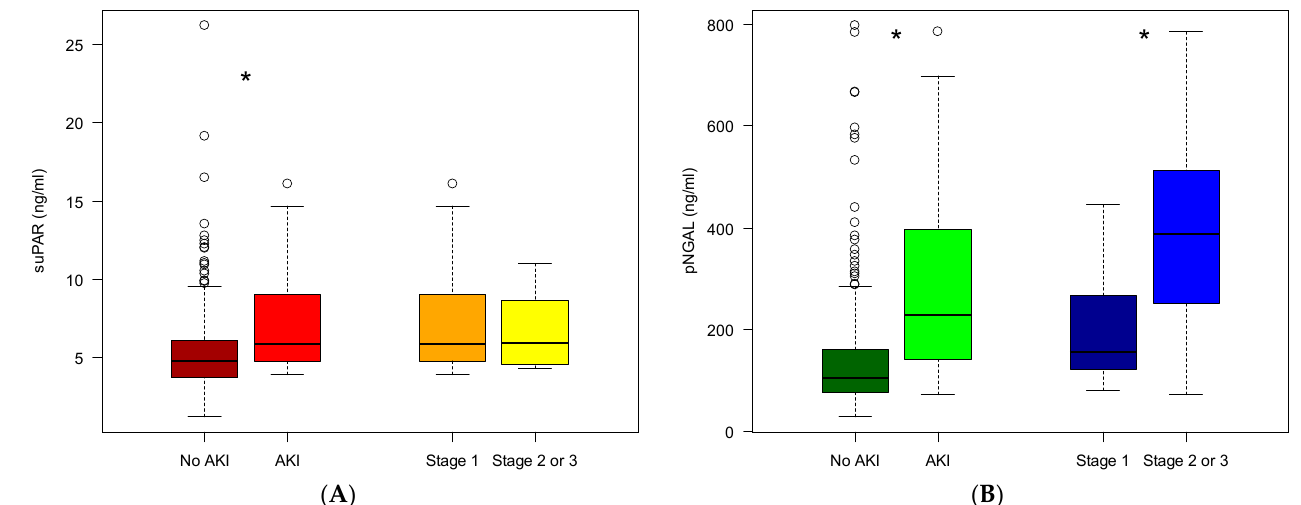
Figure 1. Plasma concentration of suPAR and NGAL at inclusion. ( A ) suPAR values in patients: without AKI (brown), developed AKI (red) within 48 h after inclusion, developed AKI stage 1 (orange), developed AKI stage ≥ 2 (yellow). ( B ) NGAL values in patients: without AKI (dark green), developed AKI (light green) within 48 h after inclusion, developed AKI stage 1 (dark blue), developed AKI stage ≥ 2 (light blue). The horizontal lines show minimum and maximum values of calculated non-outlier values; open circles indicate outlier values (* p < 0.05).